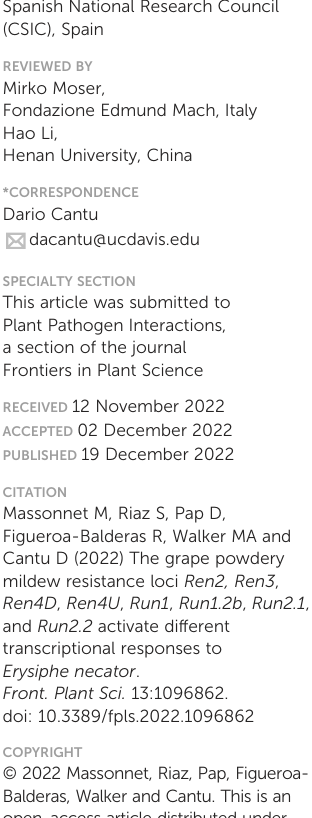
Figueroa-Balderas R, Walker MA and Cantu D (2022) The grape powdery mildew resistance loci Ren2, Ren3 , Ren4D , Ren4U , Run1 , Run1.2b , Run2.1 , and Run2.2 activate different transcriptional responses